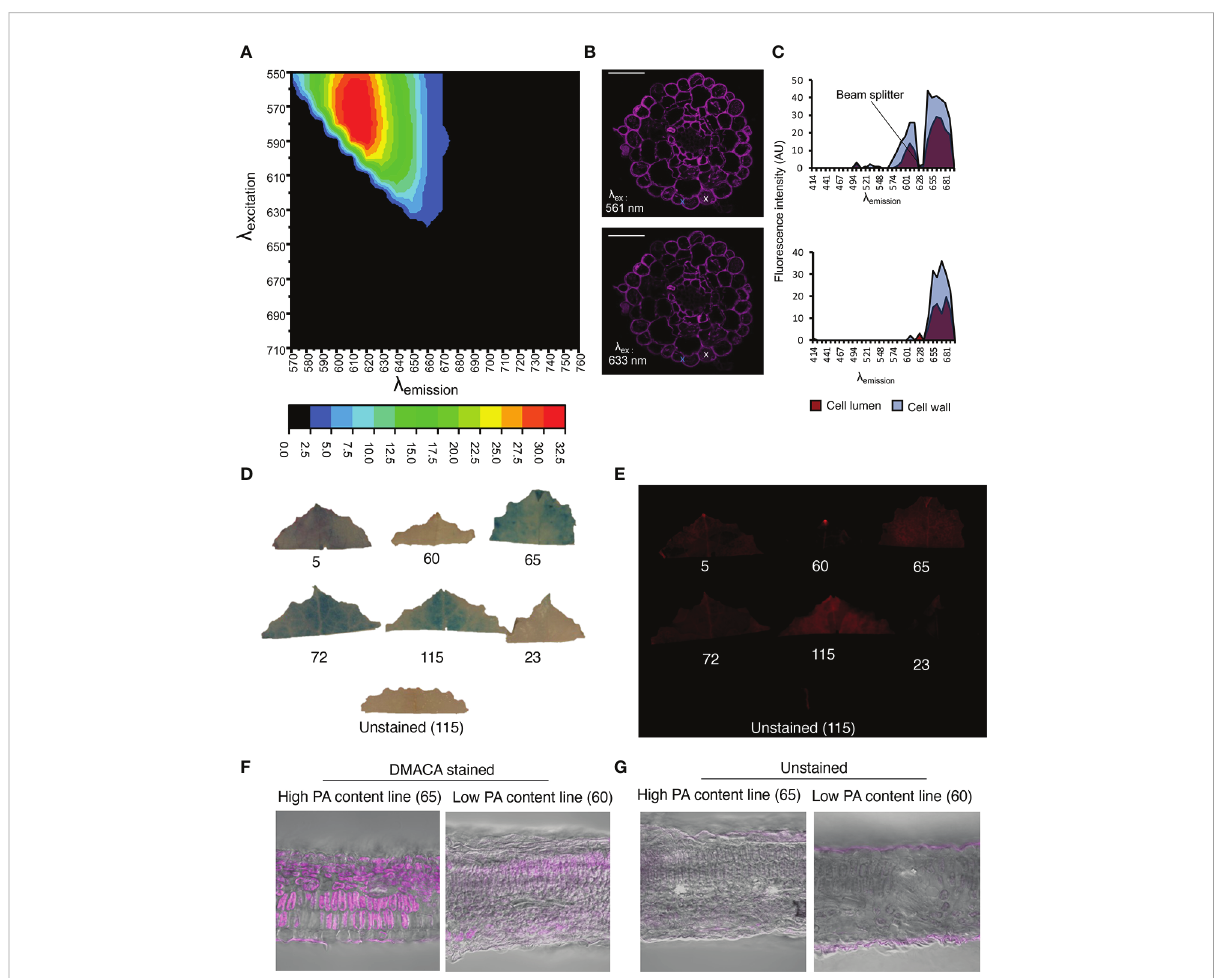
FIGURE 3 PA detection by DMACA detection in Populus root and leaf material. The relative fl uorescence intensity of DMACA-stained poplar roots depends on the selected excitation and emission wavelengths: (A) Contour plot showing the relative fl uorescence intensity (colored scale) for various combinations of excitation and emission wavelength ( l ) acquired through a lambda-lambda scan with a tunable white light laser. (B) DMACA- stained poplar root images from two lambda scans upon excitation with two commonly used confocal laser lines 561 nm and 633 nm (within the excitation area shown in the contour plot). Scale bars = 50 µm. (C) Comparison of tissue spectral representations of cell lumen and cell wall areas excited with 561 nm (upper graph) and 633 nm (lower graph) laser lines. The spectra were identi fi ed with linear unmixing tools in Zeiss Zen software by manually using the cross tool to mark the cell lumen and cell wall areas. The spectra of vacuolar PAs and cell-wall-bound PAs showed comparable emission ranges in the red region of the spectrum, as shown in Figure 1. (D – G) Detection of PAs with DMACA in Populus tremula genotypes from the Swedish Aspen Collection (SwASP) with different leaf PA levels (Bandau et al., 2015). The ID number corresponds to the SwAsp ID. (D) Light images showing PA levels as blue precipitate. (E) DMACA-stained leaves upon excitation and imaging with a fl uorescent imaging system (Azure 600c, Azure Biosystems) using the red channel ( l ex / l em = 650 nm/670 nm). Leaf section of P. tremula lines with high and low PA content stained with DMACA (F) and imaged under the confocal microscope, overlay with bright fi eld images. Unstained sections showing background fl uorescence (G) . Scalebar in (F – G)